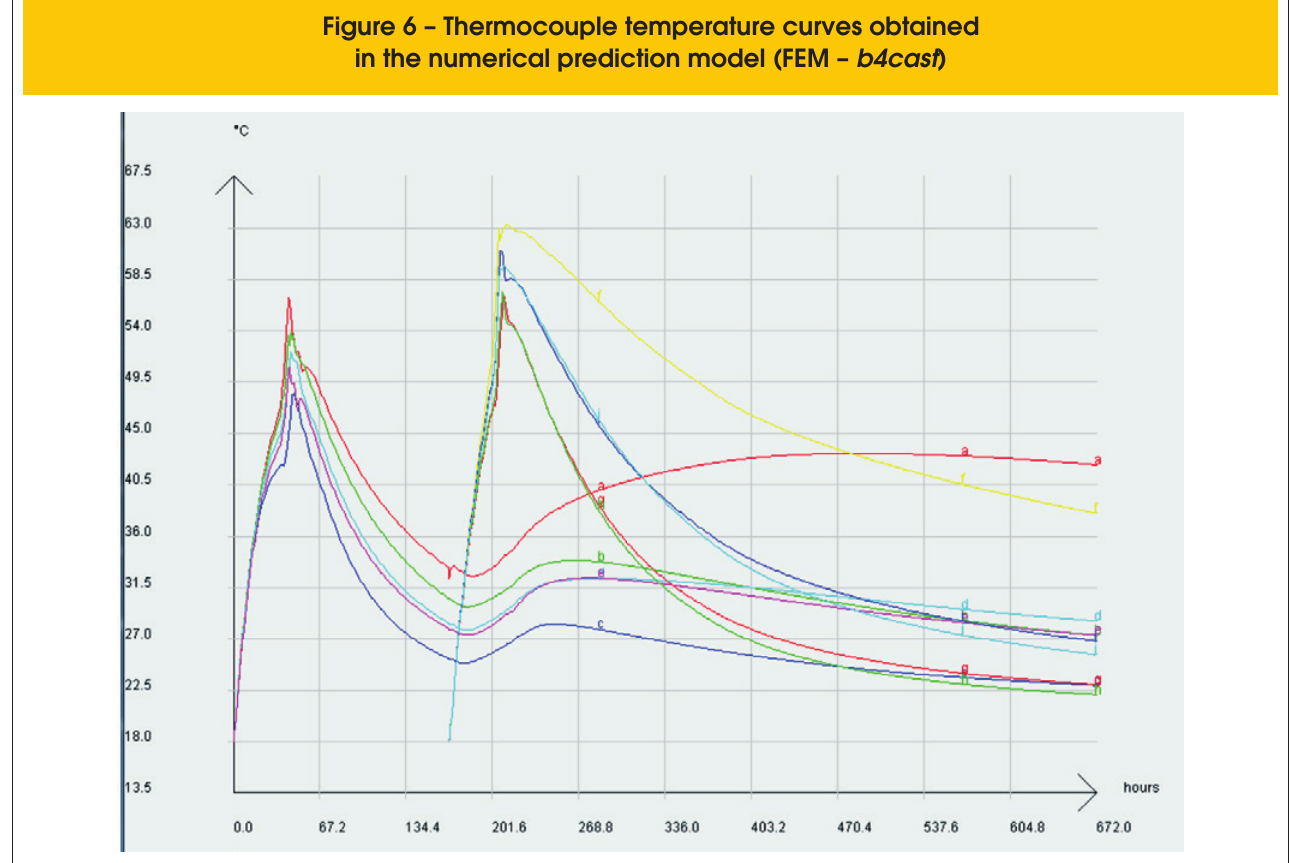
Figure 6 – Thermocouple temperature curves obtained in the numerical prediction model (FEM – b4cast